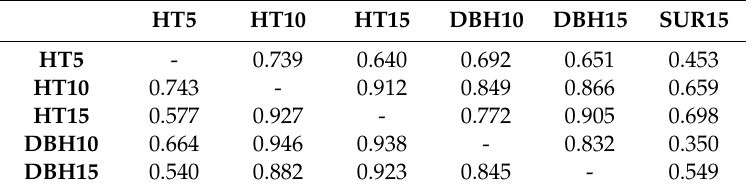
Table 2. Correlation among traits at the plot (above diagonal) and the individual (below diagonal) level. HT5 HT10 HT15